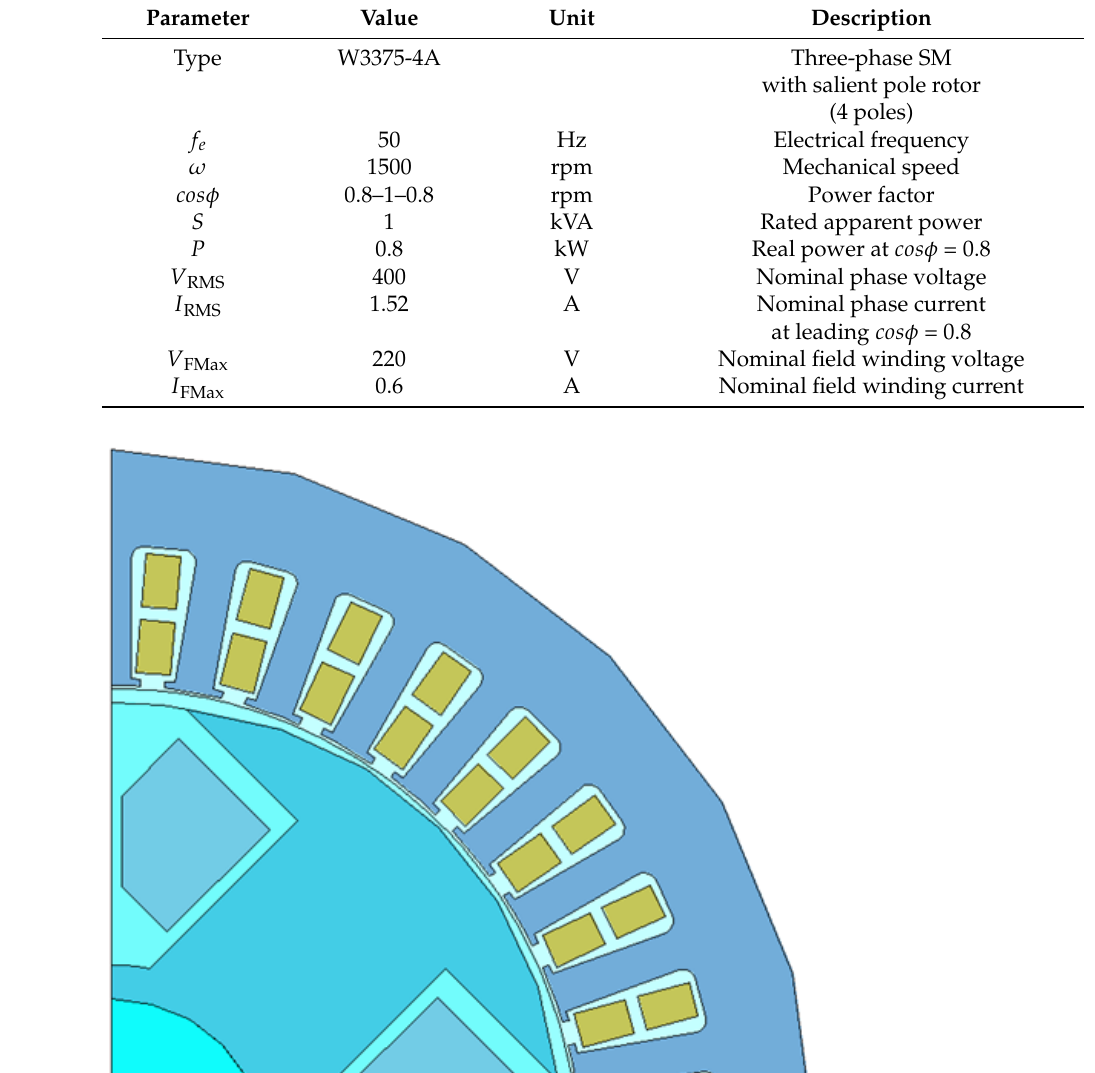
Table 2. WUEKRO WRSESM—Nominal parameters.